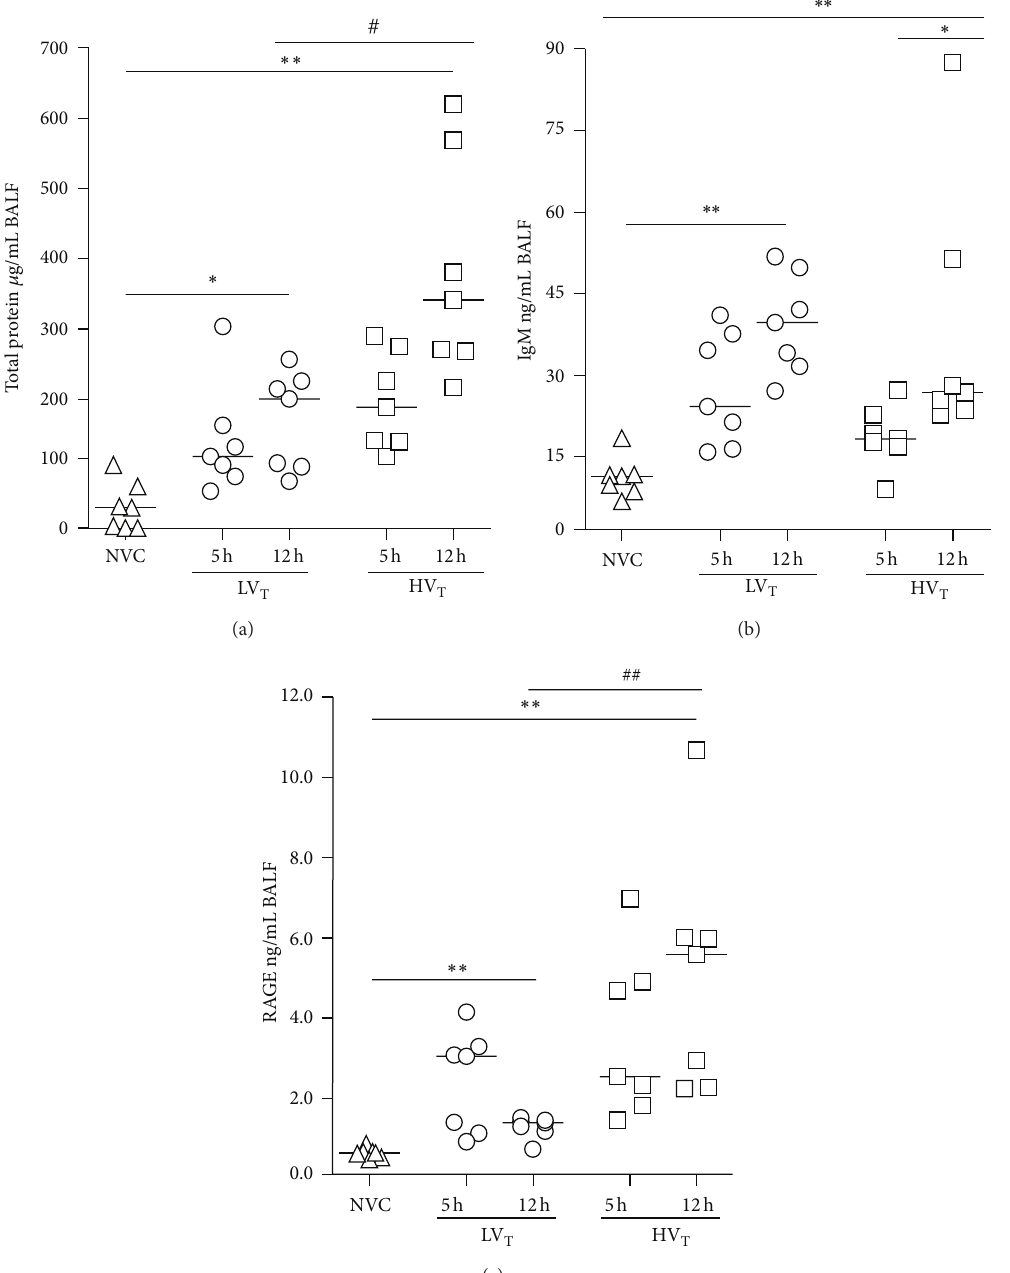
Figure4:Alveolar-capillarypermeability.((a)-(b))Alveolar-capillarypermeabilityisrepresentedbytotalproteinandimmunoglobulin(Ig)M levels in bronchoalveolar lavage fluid (BALF). (c) Alveolar epithelial type 1 cell injury is represented by receptor for advanced glycation end- products (RAGE) levels in BALF [18]. Data are presented as scatter plot (median) of 7-8 mice per group (triangle = NVC; circle = LV T ; square = HV T ). ∗ Illustrates primary statistical analysis ( ∗ 𝑃 < 0.05 , ∗∗ 𝑃 < 0.01 ); # illustrates secondary statistical analysis ( # 𝑃 < 0.05 , ## 𝑃 < 0.01 ). NVC = nonventilated controls; LV T , HV T = LV T /PEEP or HV T /ZEEP ventilator settings; 5 h, 12h = 5 or 12 hours of